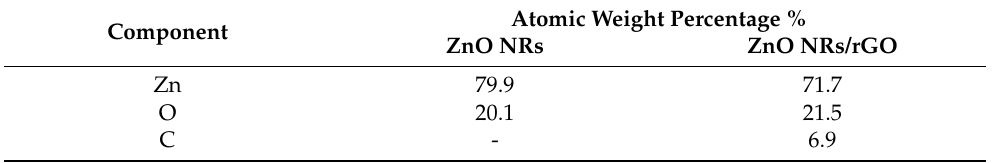
Table 2. Quantitative analysis of